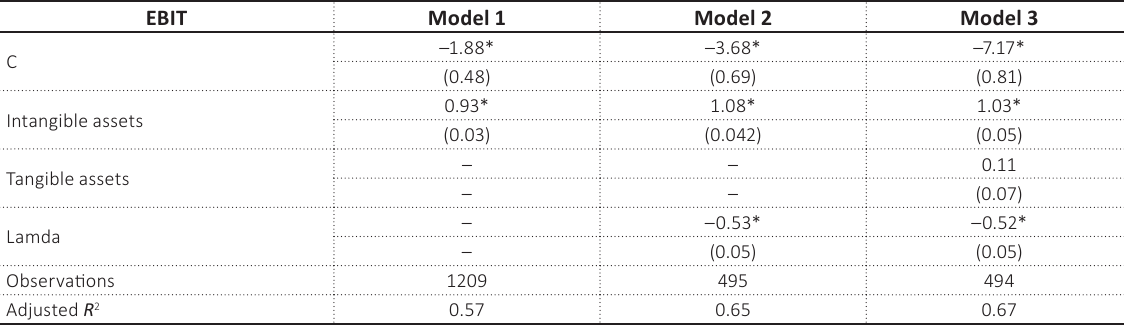
Table 7. The impact of intangible assets on stock prices